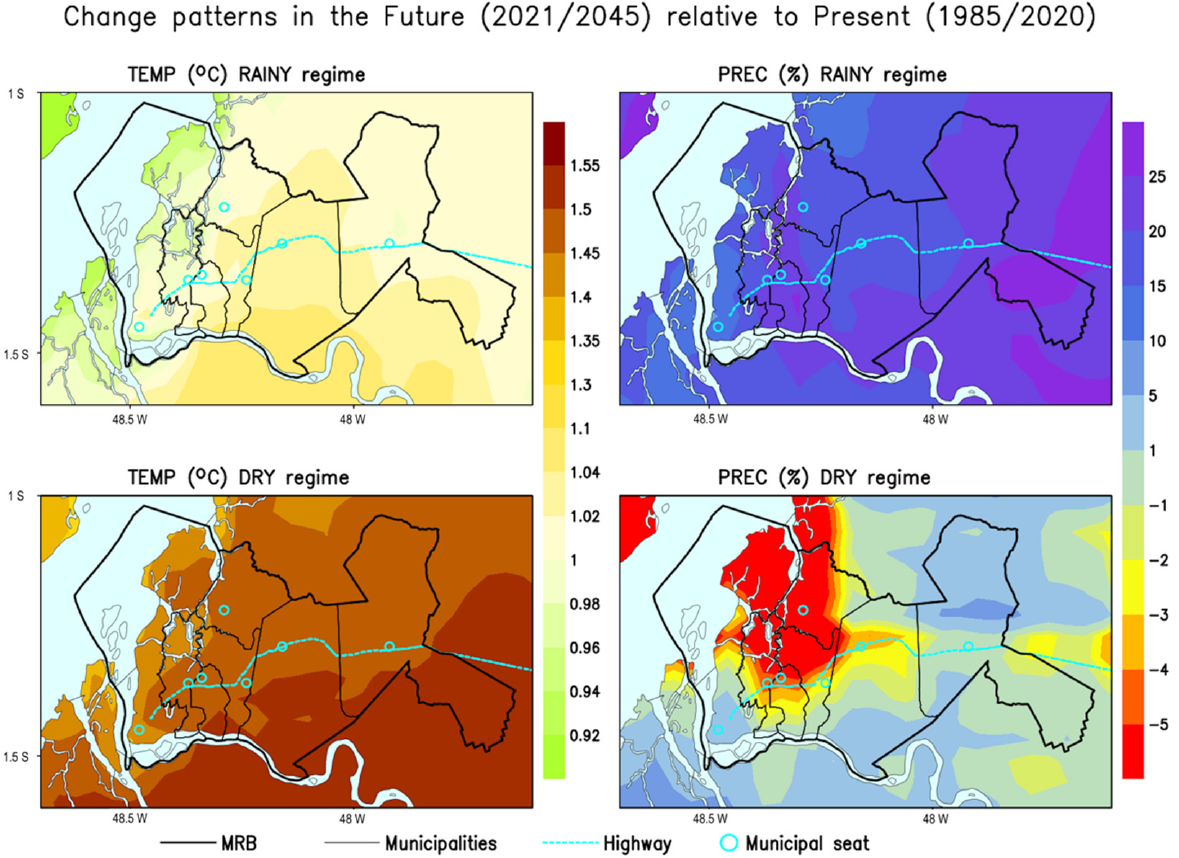
Figure 11. Change patterns of future (2021/2045) relative to present (1985/2020) for TEMP ( left panel) and PREC ( right panel) in the RAINY and DRY regimes. The color bar indicates TEMP in °C and PREC in %.